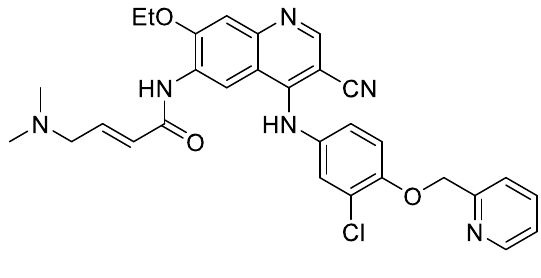
Figure 7. Chemical structure of neratinib.